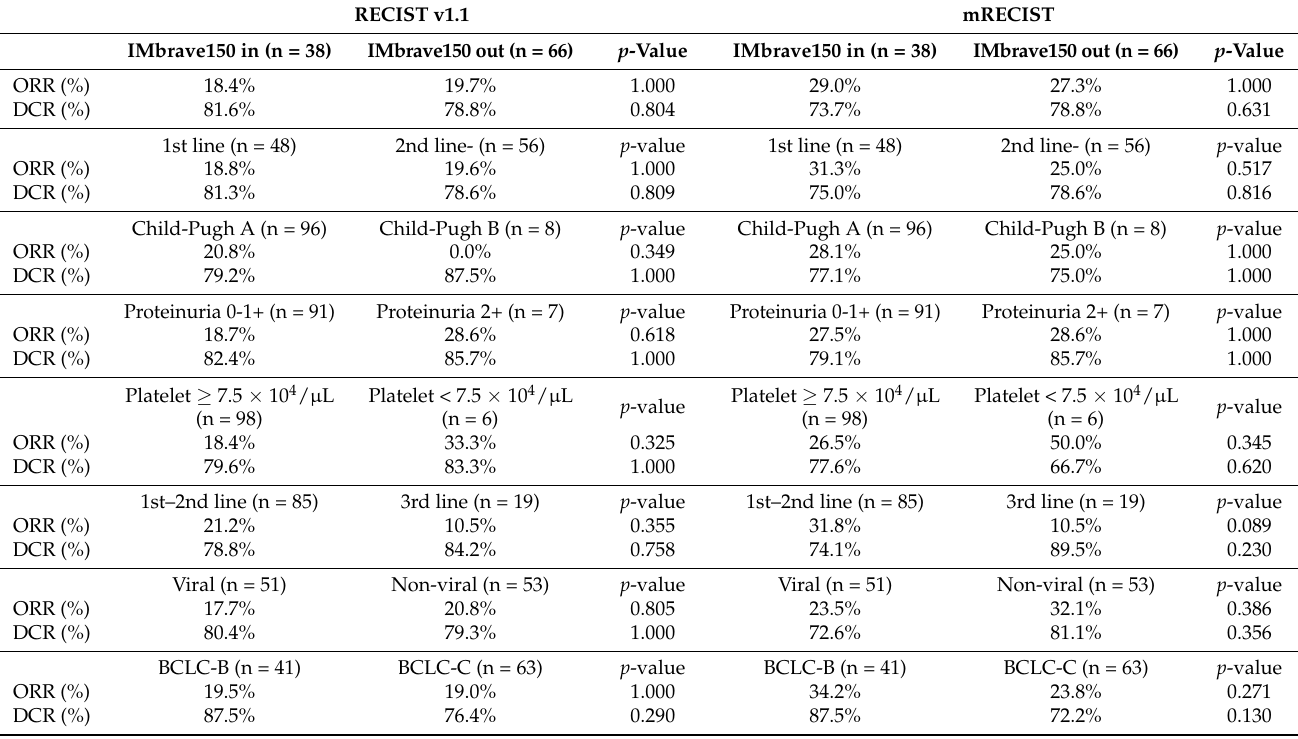
Table 3. Comparison of clinical responses in patients who were treated with atezolizumab and bevacizumab in each